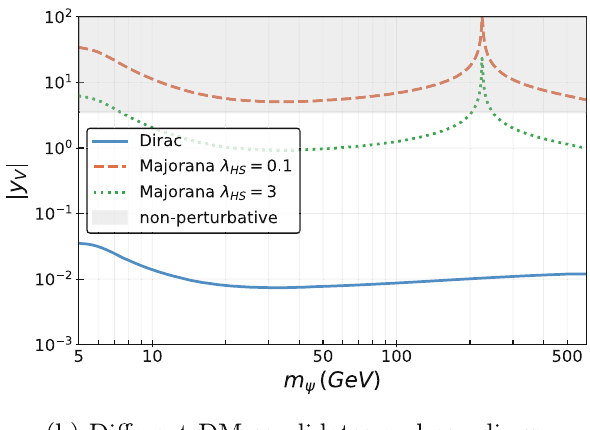
= 0 and φ = 1 . 4. Unless specified the Higgs portal coupling is φ V A λ = 0 . 1. We highlight in gray the region where the Yukawa coupling √ HS is non-perturbative, | y V | > 4